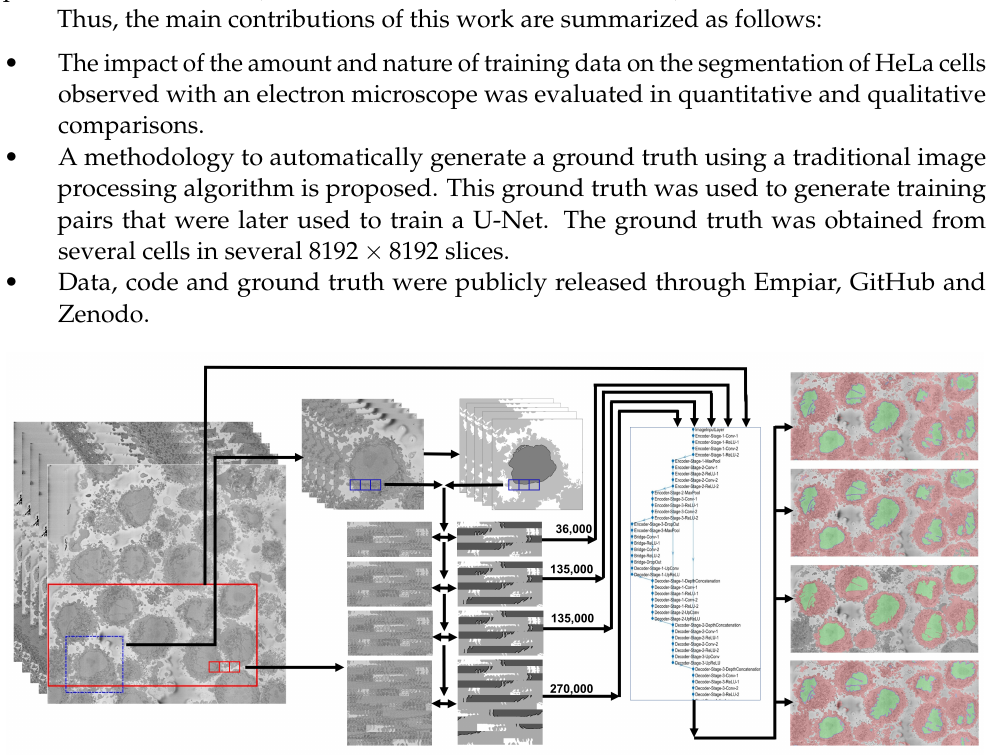
Figure 1. Graphical abstract of the framework analysed in this paper. The input data consist of 517 electron microscope images with dimensions 8192 × 8192 pixels. A region of interest (ROI) (blue box) of 300 images each 2000 × 2000 was cropped and manually labeled into 4 classes (nucleus, nuclear envelope, cell, and background) to generate a ground truth. Pairs of patches of data and labels were generated and used to train a U-Net architecture with different strategies: 36,000 pairs, 135,000 pairs from a single cell, 135,000 from all the dataset extracted automatically with the image processing algorithm, and finally 270,000 with 135,000 from the ROI and 135,000 from other cells. The segmentations for the ROI were evaluated quantitatively, and the accuracy and Jaccard index were calculated. For a larger subsection of the data (red box), the evaluation was qualitative due to lack of ground